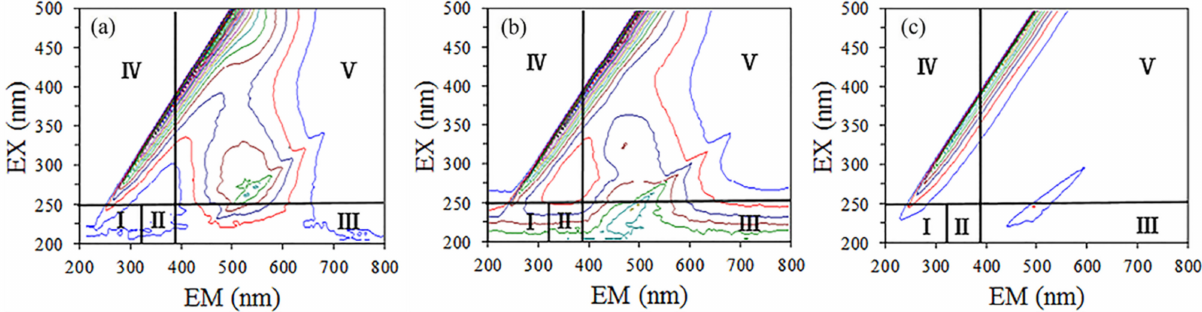
Figure 6. Time-varying 3D-EEM spectra of HA in UV/SPB system. ( a ) 0 min, ( b ) 15 min, ( c ) 60